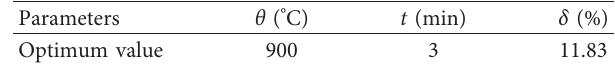
Table 10: Optimum values for